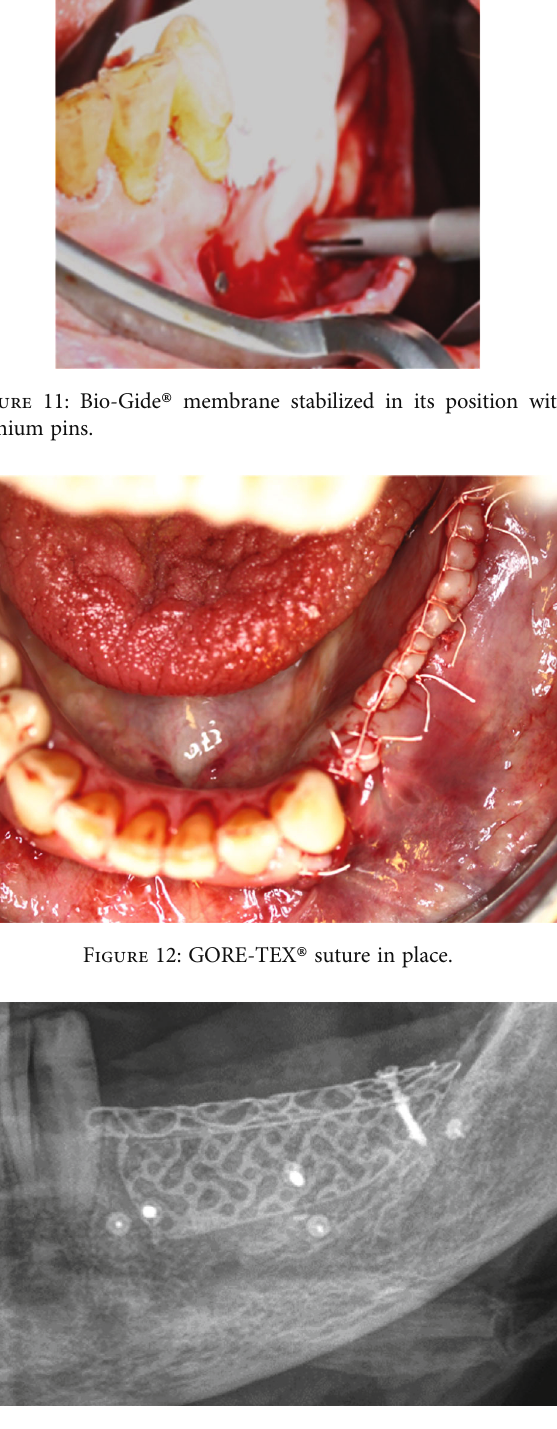
Figure 13: DPT section after GBR surgery was